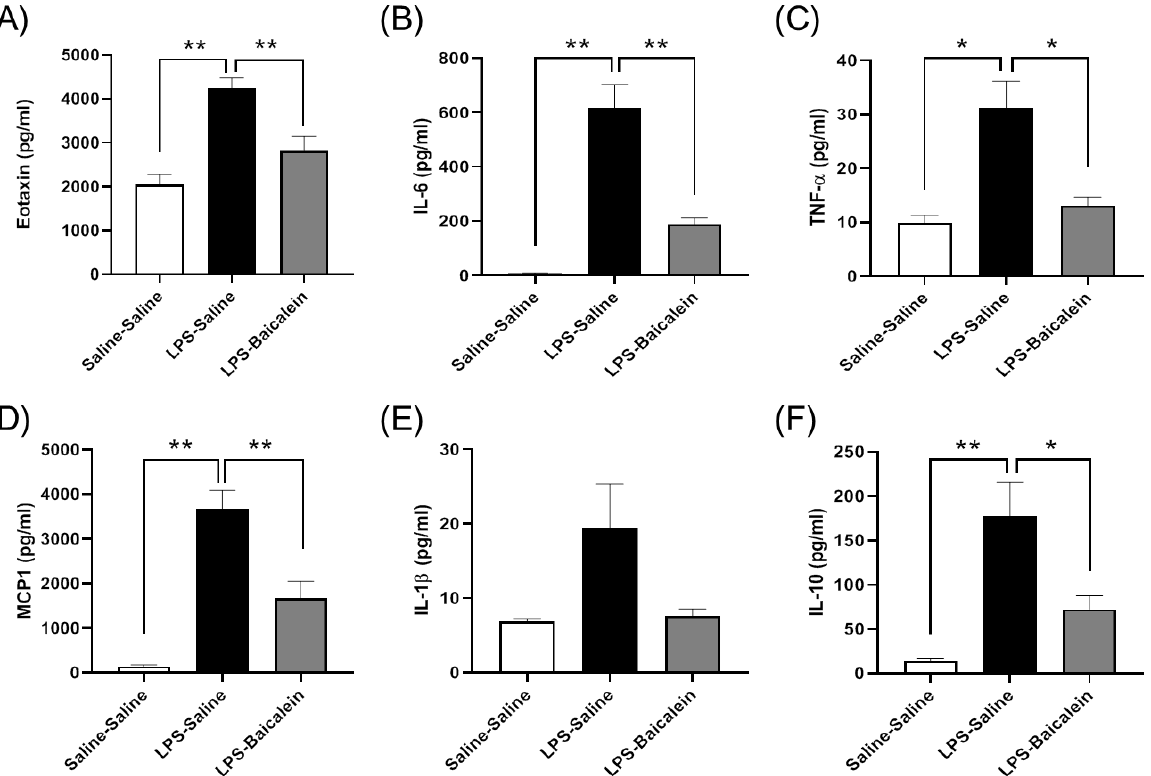
Figure 4. Effect of baicalein on the levels of cytokines in the plasma of mice. ( A – F ) The levels of cytokines increased in plasma after the administration of LPS (5 mg/kg, i.p.). Treatment with baicalein (3 mg/kg, i.p.) after 1 h following LPS administration significantly reduced the levels of cytokines. ( A ) Eotaxin. ( B ) IL-6: interleukin-6. ( C ) TNF- α : tumor necrosis factor- α . ( D ) MCP1: monocyte chemoattractant protein-1. ( E ) IL-1 β : interleukin 1 β . ( F ) IL-10: interleukin-10. Data are presented as means ± SEM. ( n = 6) * p < 0.05, ** p < 0.01.